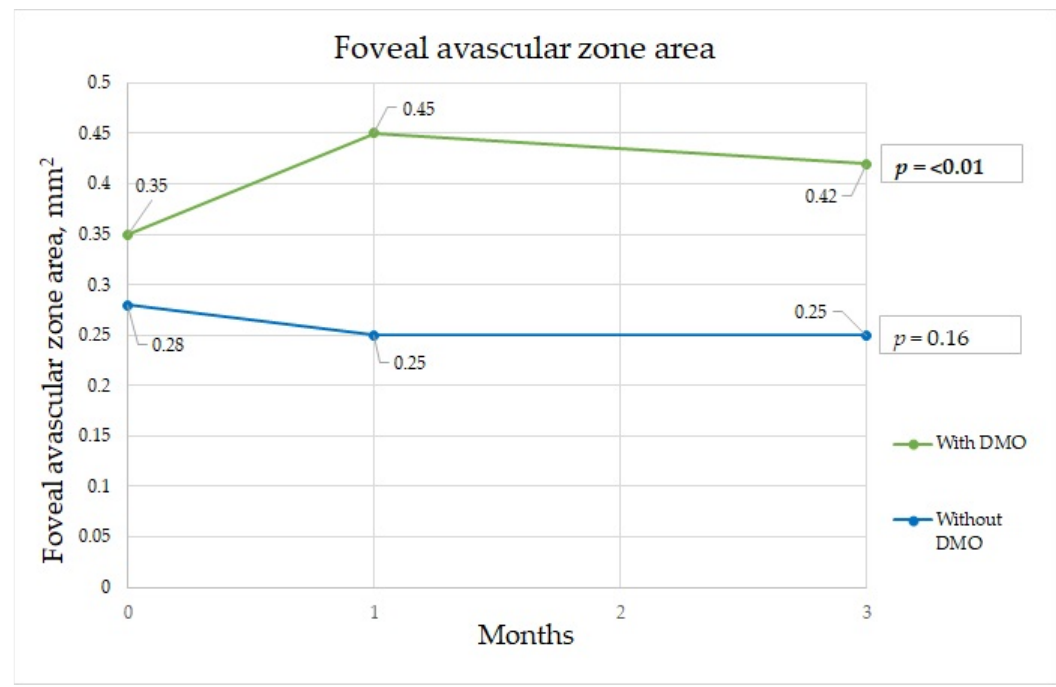
Figure 1. Foveal avascular zone changes during three-month period.